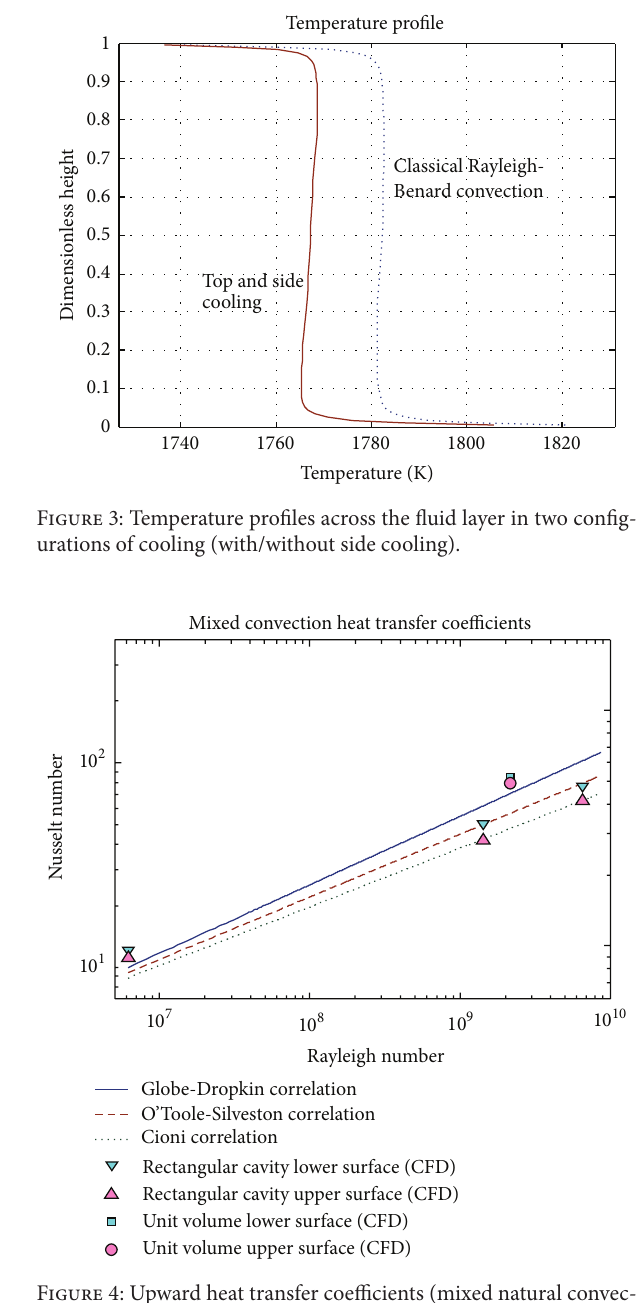
Figure 4: Upward heat transfer coefficients (mixed natural convec-